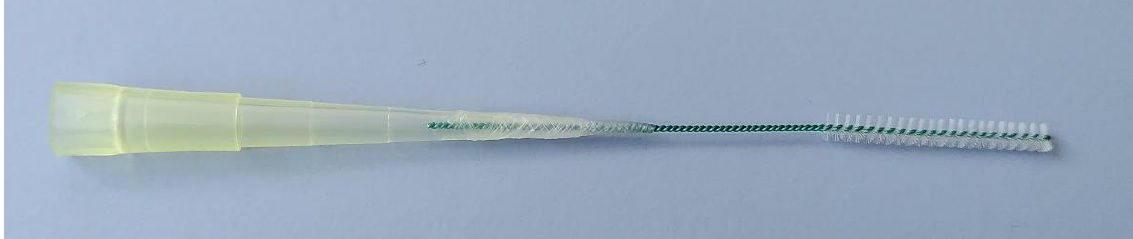
Figure A1. Interdental brush elongated by attaching a 200- μL pipette tip with parafilm.